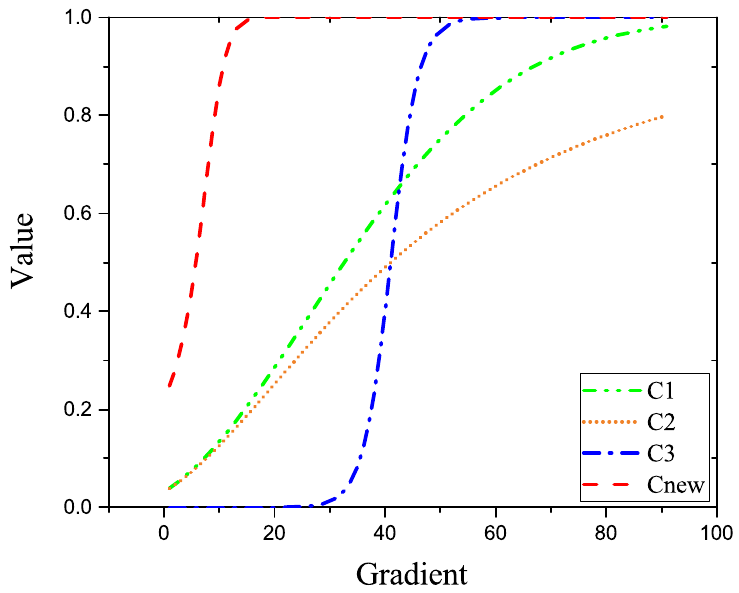
Figure 2. Comparison of gradient perception of kernel diffusion function. All functions were plotted for k =